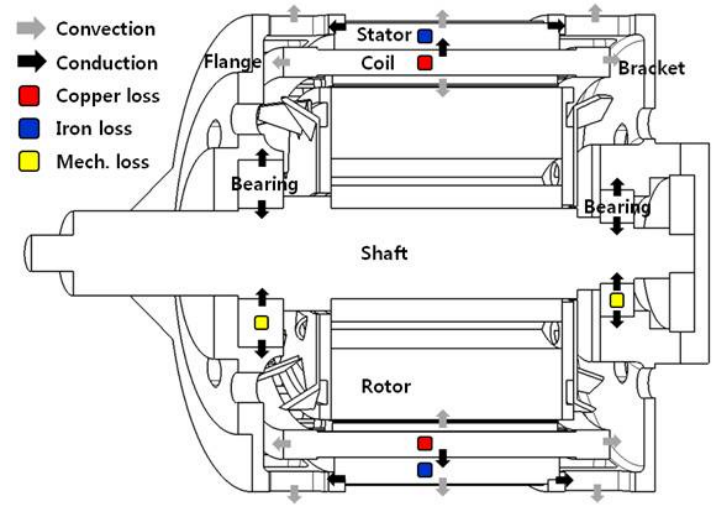
Figure 9. Heat transfer paths in the